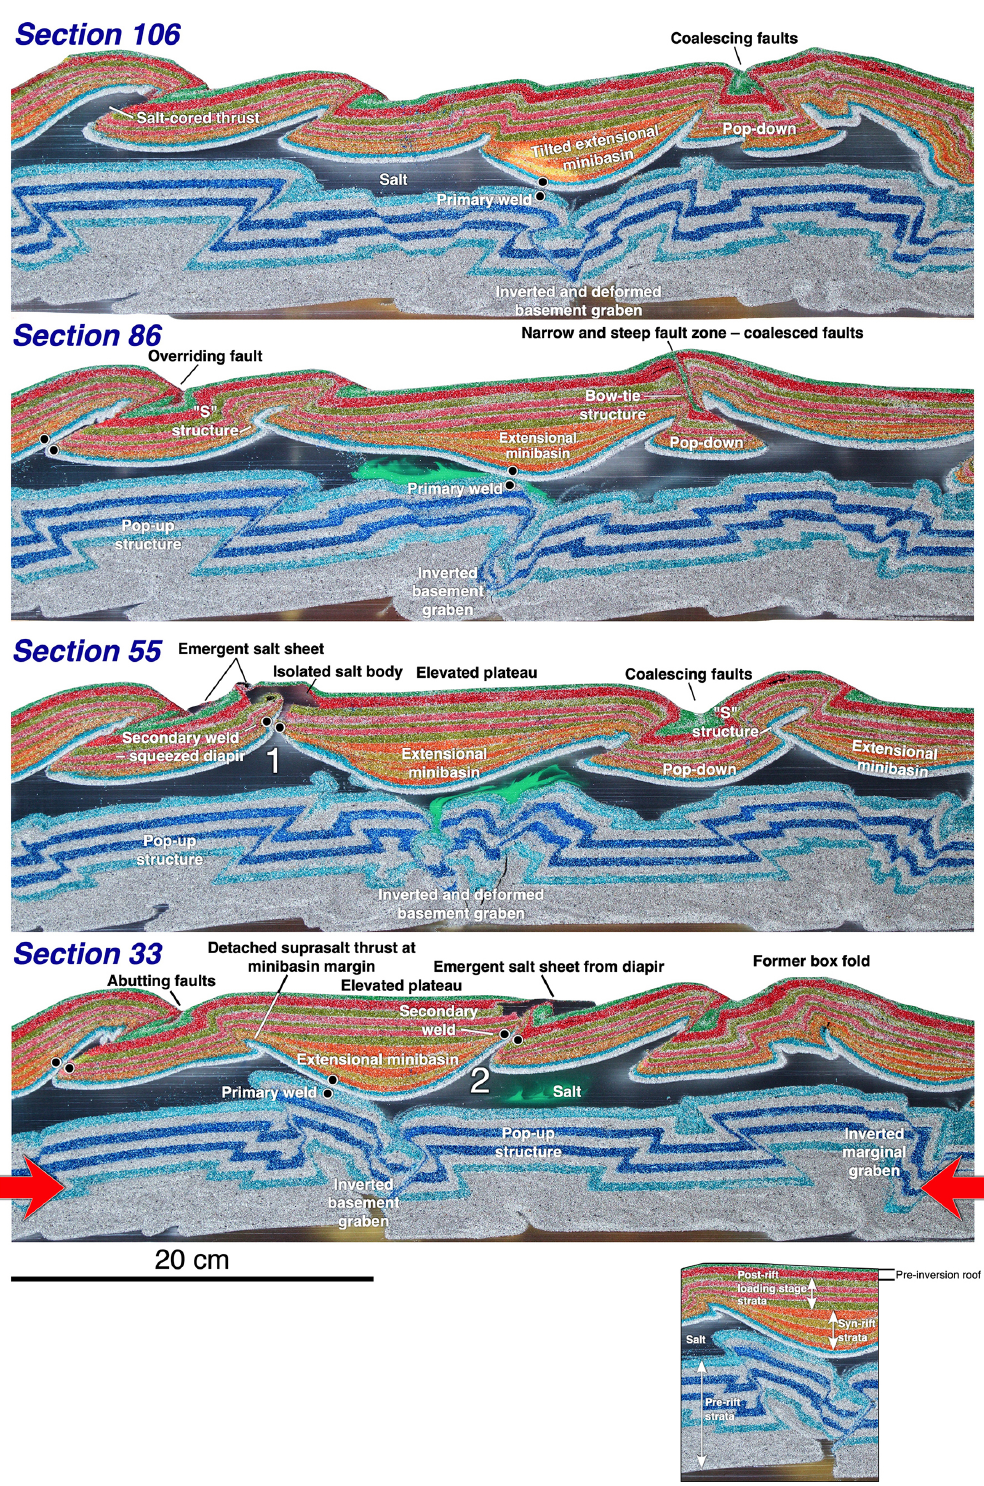
Figure 9. Representative sections through Model 1. Locations are shown in Fig. 8. Inset shows the model